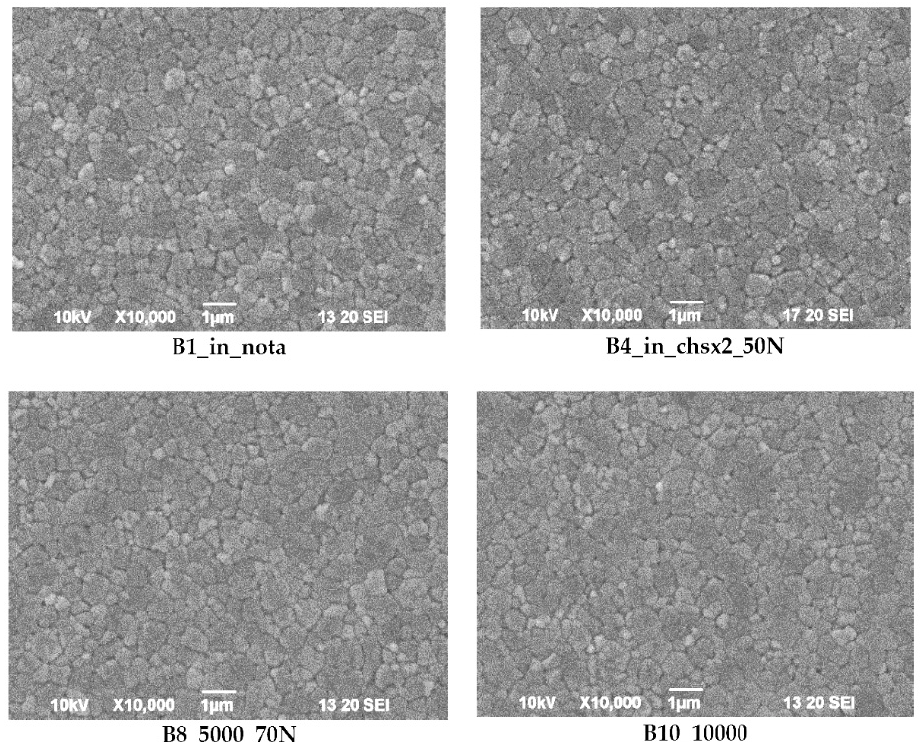
Figure 8. SEM images of thermally etched crown microstructures.